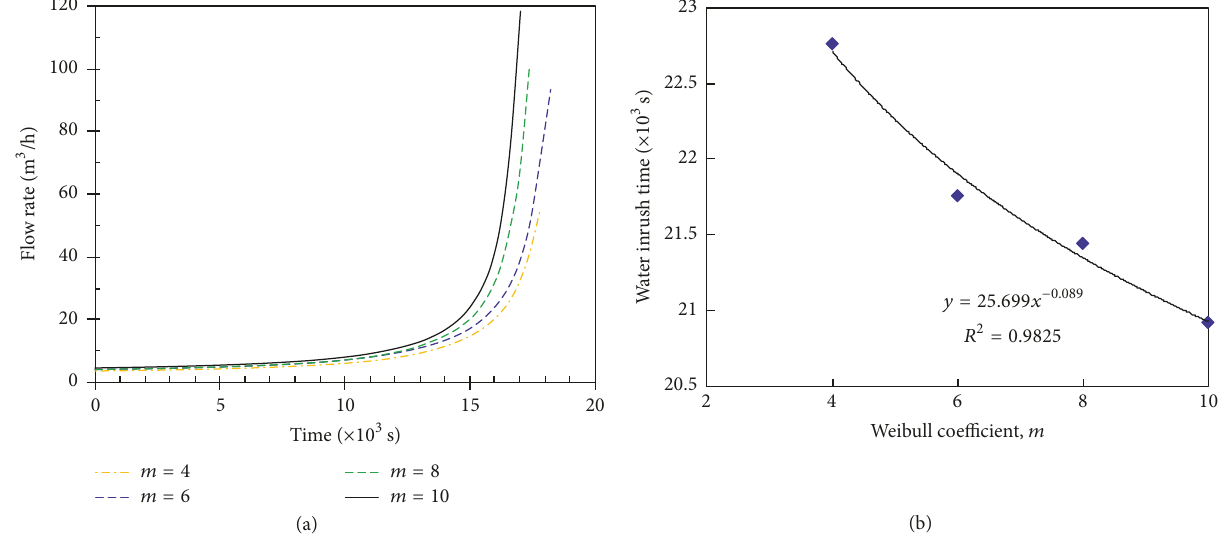
Figure 24: Impact of heterogeneity on water flow rate (a) and inrush time (b).